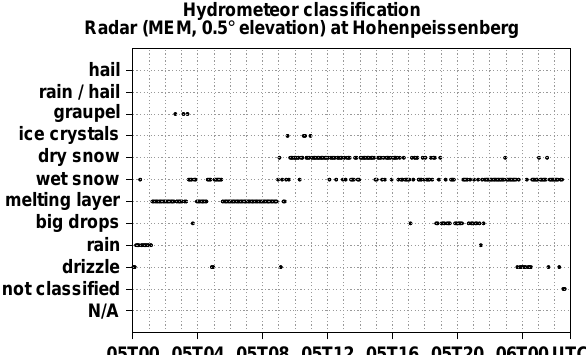
Figure 17. Time series of the hydrometeor classification for the 0.5 ◦ elevation volume sweep of radar MEM at the position of MHP. At this location the radar ray has a mean vertical extension of 1127m and the height of the ray bottom is estimated at 959ma.s.l. Dis- played are the distinct hydrometeor classes with the highest detec- tion